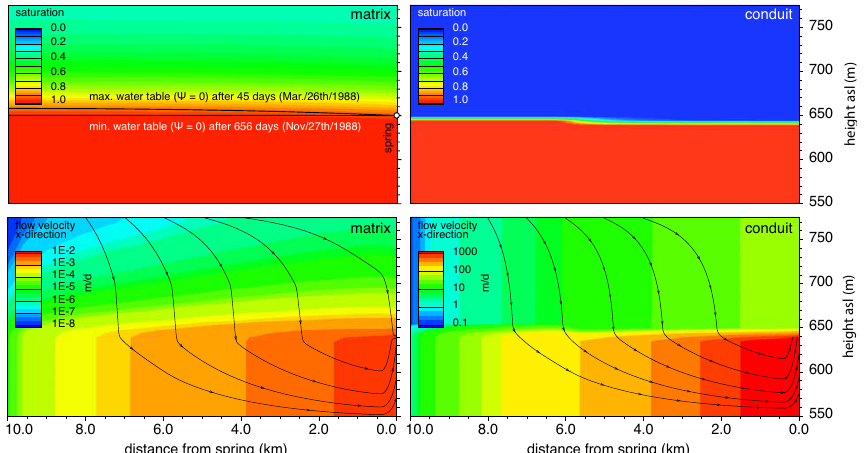
Fig. 5. Results of the transient flow model (26 March 1988). Shown water tables apply for both continua as the height is nearly equal and differs 1cm at most. The van Genuchten parameter α m leads to a strong difference between the continua. The capillary rise is more pronounced in the matrix system, where saturation is ca. 0.35 near the surface. Saturation in the conduit system is lower than 0.1 above the water table and below 0.0001 near the surface. Flow velocities (only x-direction vector, note the different scaling for matrix and conduits) are apparently higher in the conduit continuum.